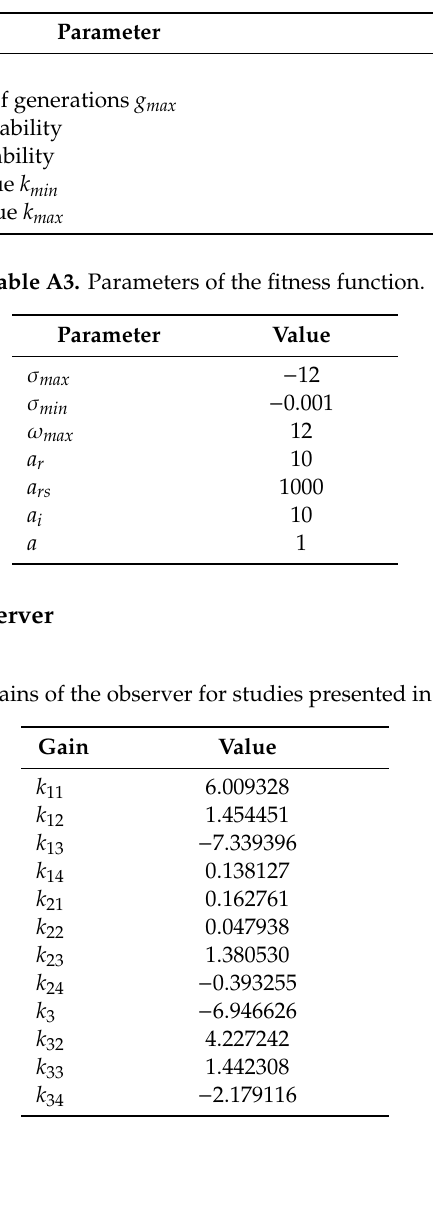
Table A2. Parameters of genetic algorithm.